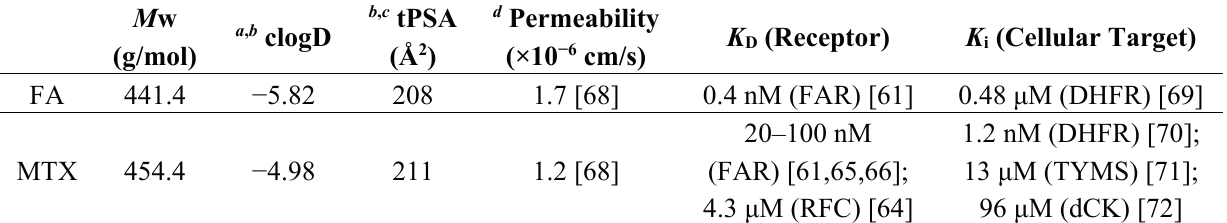
Table 1. Summary of physicochemical properties and pharmacology of folic acid (FA) and methotrexate